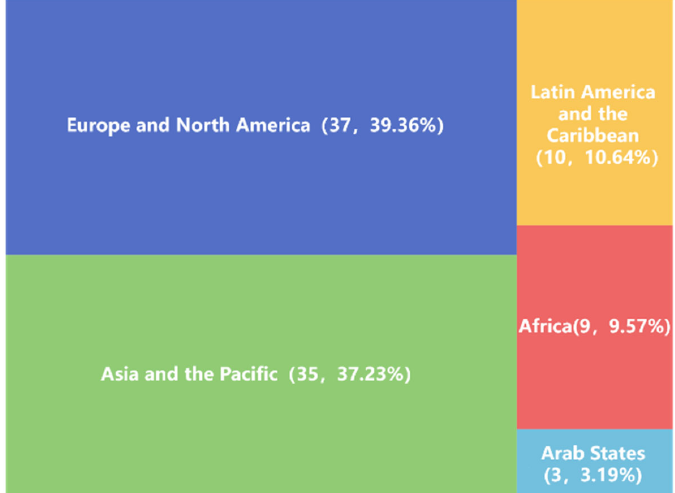
Figure 8. Distribution of world cultural heritage sites with a variation in distance greater than 7.60 km